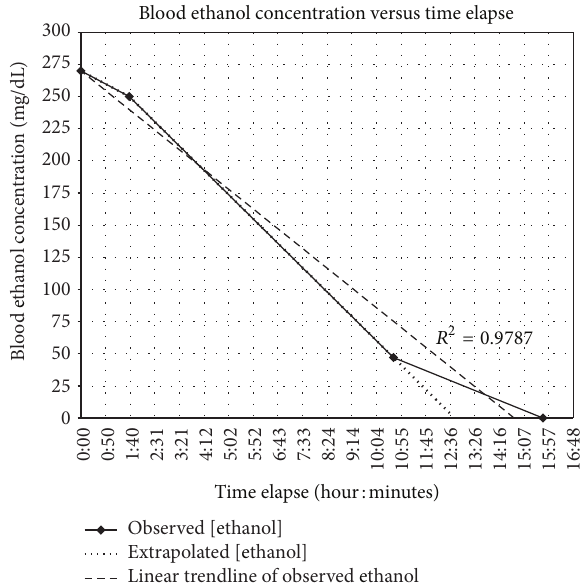
Figure 1: Blood ethanol concentration (mg/dL) versus time (hr: min). (—) represents actual measure concentrations of ethanol and their corresponding times. ( ⋅⋅⋅ ) represents an extrapolated line measured from the previous 2 points to show that if the infant had continued linear elimination, he would have completely eliminated the ethanol at 12 hours and 45 minutes. (---) represents a linear trendline applied to the actual measured ethanol concentrations and their corresponding times to suggest linear, or zero-order, elimination kinetics with a coefficient of determination (𝑅 2 ) = 0.9787